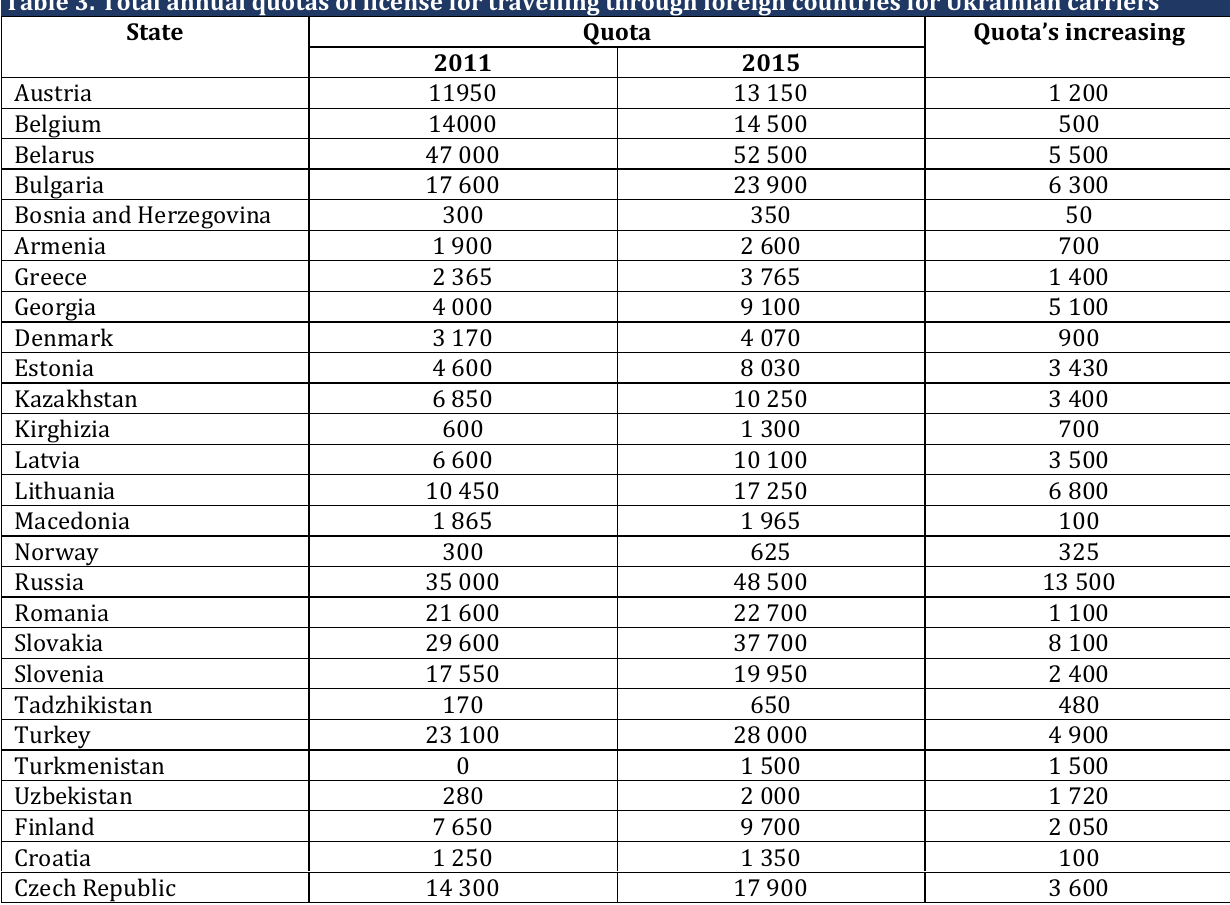
Table 3. Total annual quotas of license for travelling through foreign countries for Ukrainian carriers State